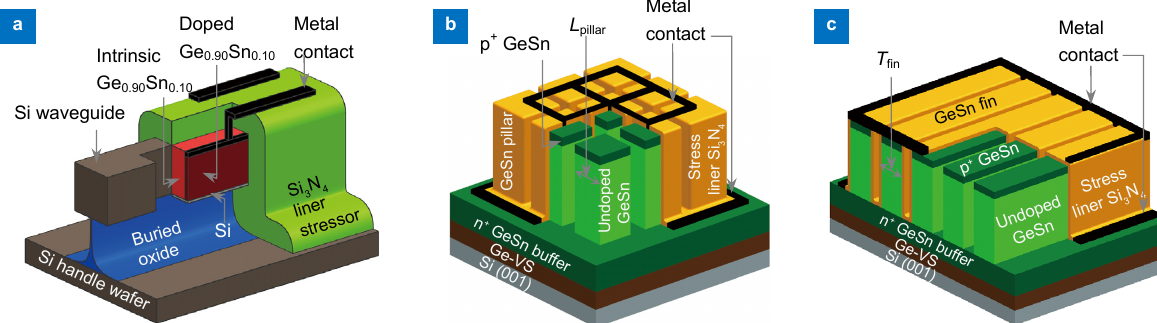
Fig. 1 | 3D schematics of the designed GeSn photodetectors based on different architectures . ( a ) GeSn on SOUP waveguide integrated with the Si 3 N 4 liner stressor. Three-dimensional schematics of GeSn detectors with ( b ) pillar and ( c ) fin array integrated with the Si 3 N 4 liner stressor on Si platform. Figure reproduced from: ( a ) ref. 26 , Optical Society of America; ( b , c ) ref. 33 , IEEE.